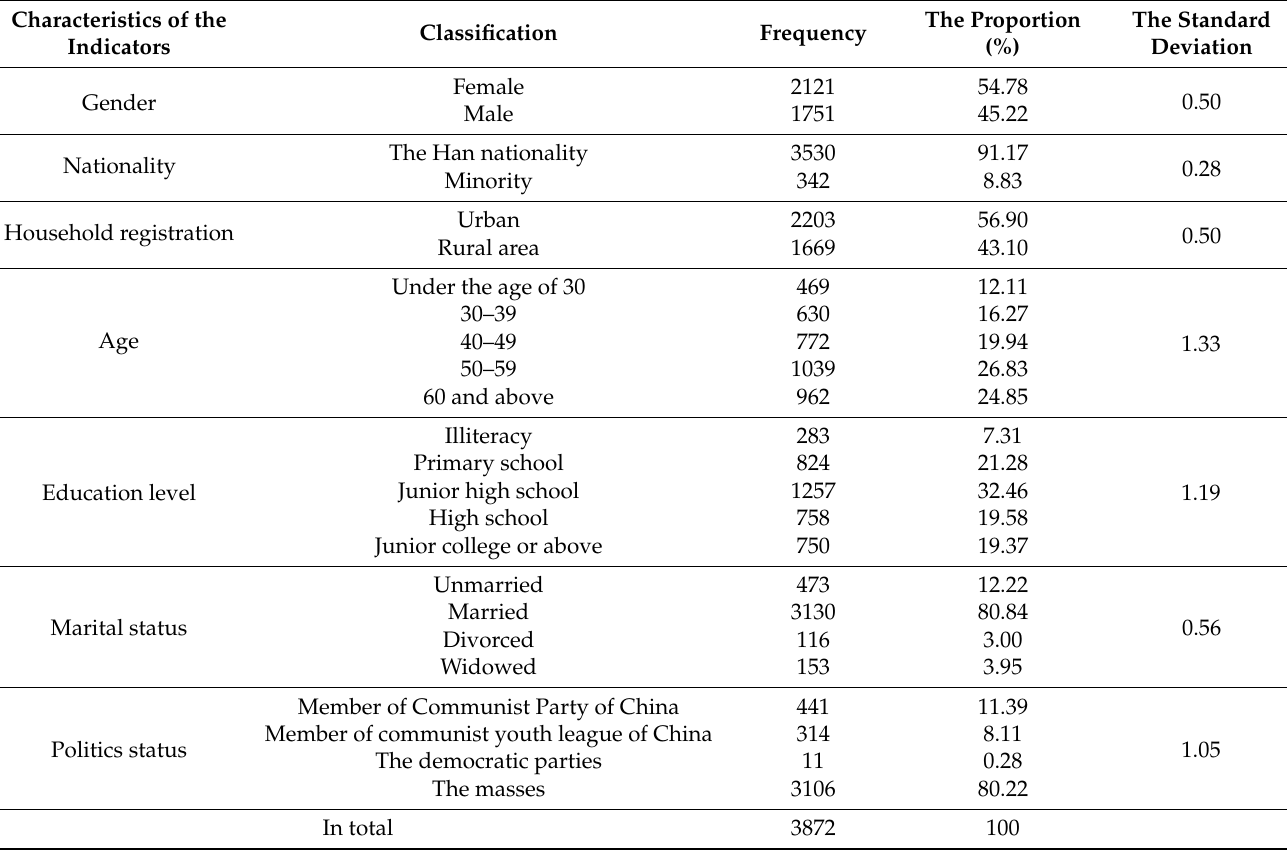
Table 1. Characteristics of the survey